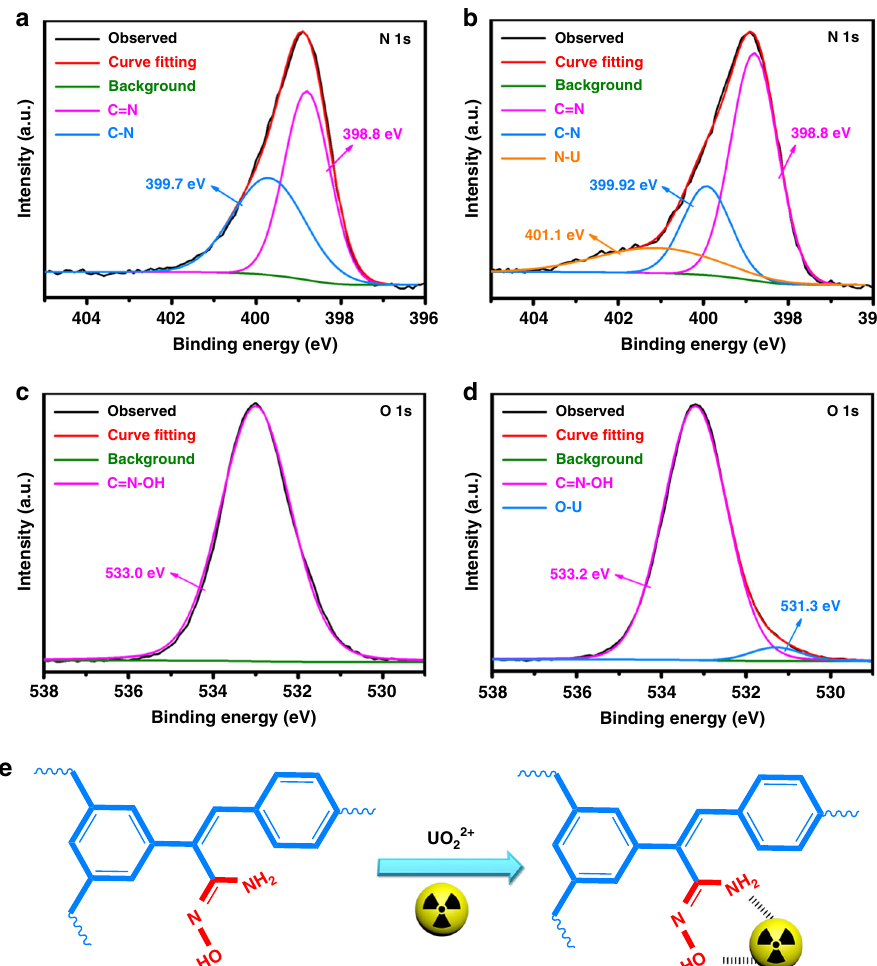
Fig. 5 XPS data, fi ts, and interaction between TFPT-BTAN-AO and UO 2 2 + . XPS spectra of the N 1 s region of TFPT-BTAN-AO a before and b after treatment with UO 2 2 + . XPS spectra of the O 1 s region of TFPT-BTAN-AO c before and d after treatment with UO 2 2 + . e Schematic diagram of the interaction between TFPT-BTAN-AO and UO 2 2 +